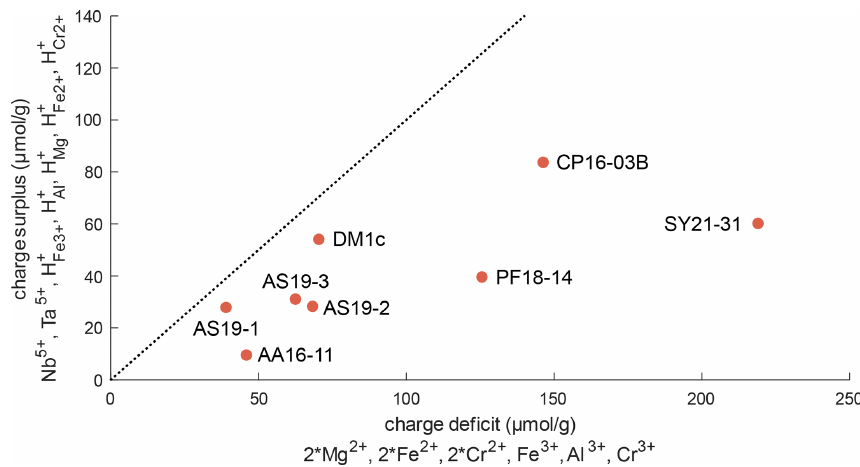
Figure 11. Charge balance of di-, tri-, and pentavalent cations and trace-element-related H + , excluding Ti 3 + . The dotted line represents a 1:1 ratio between “charge deficit” and “charge surplus”. The position of all samples below this line indicates an excess of di- and trivalent cations that can be balanced by oxygen